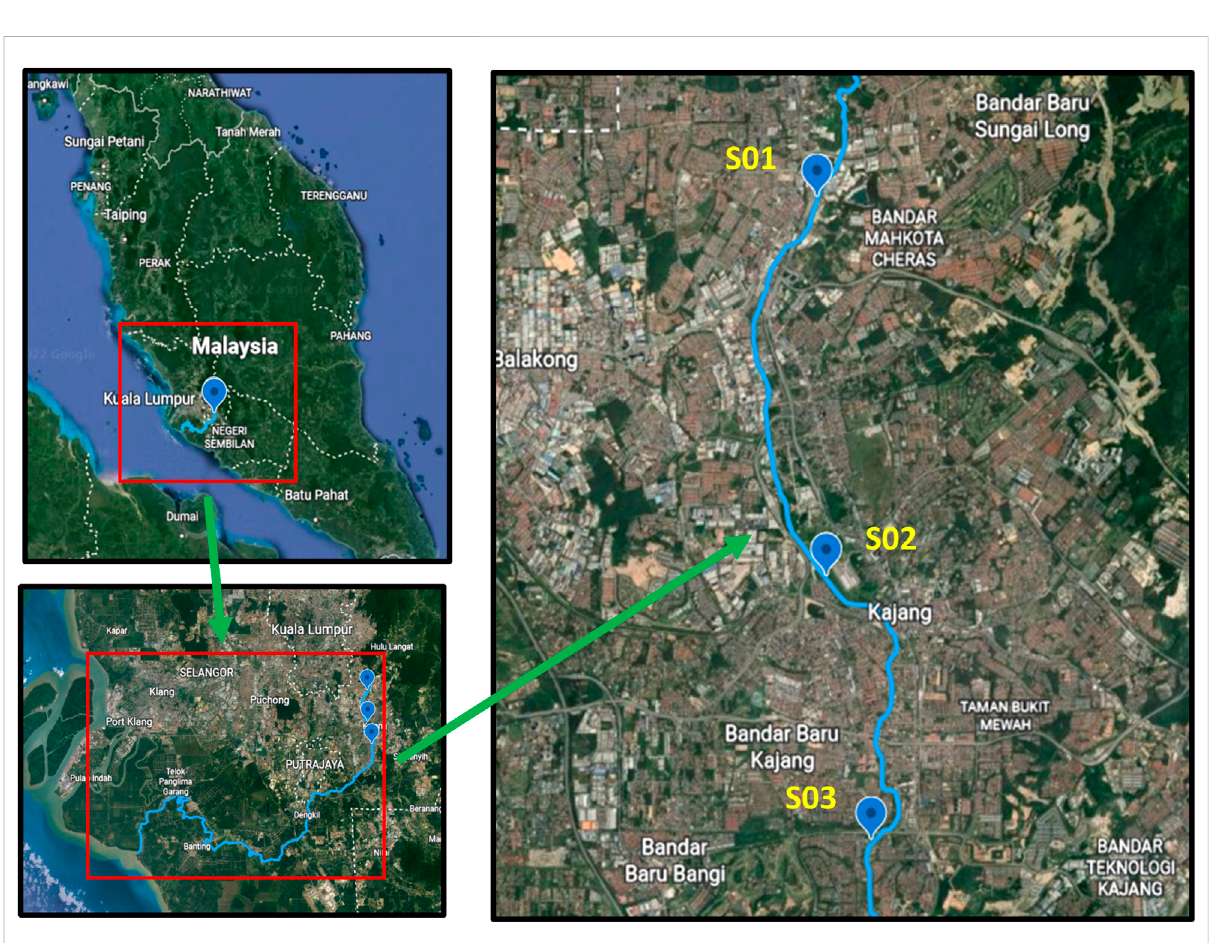
FIGURE 1 Water quality monitoring stations of the Langat